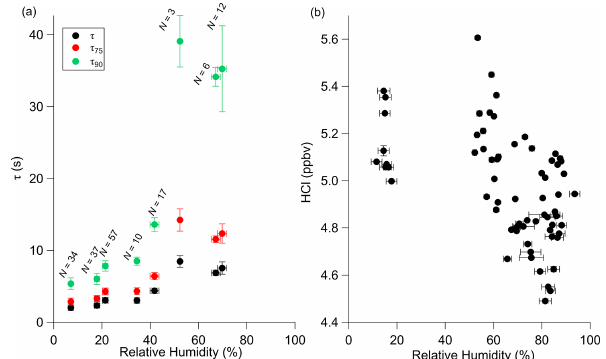
Figure 7. Effects of changes in relative humidity on τ during labora- tory experiments (a) and HCl standard mixing ratios in the field (b) . Relative humidity values are based on the TILDAS-observed water mixing ratio observed during the HCl decay period (a) or HCl stan- dard addition (b) and concurrent temperature reading. Error bars for both axes represent 1 standard